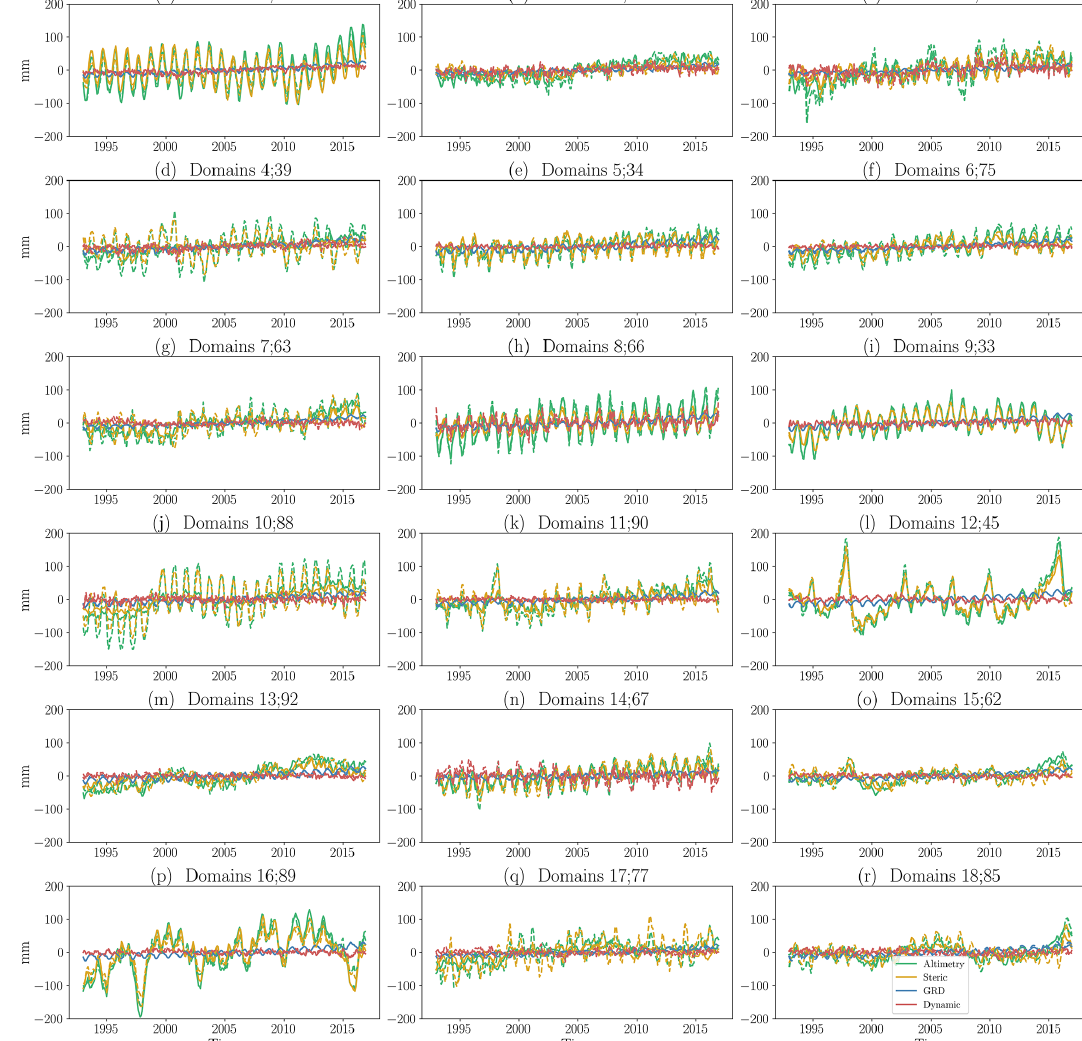
Ocean Sci., 19, 17–41, 2023